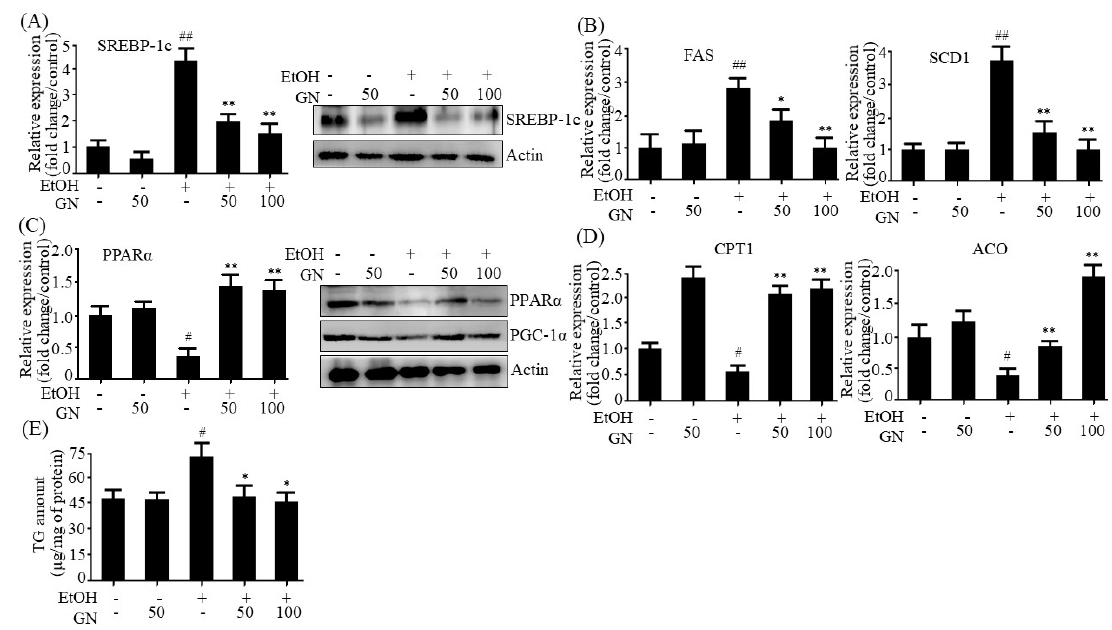
Figure 6. Gomisin N prevents ethanol-induced intracellular TG accumulation in HepG2 cells. HepG2 cells were treated with 50 mM ethanol in the presence or absence of GN (50 or 100 μM) for 24 h. ( A ) qPCR and western blot analysis of hSREBP-1c. ( B ) qPCR analysis of hFAS, and hSCD1. ( C ) qPCR and western blot analysis of hPPARα, western blot analysis of PGC-1α. ( D ) qPCR analysis of hCPT1, and hACO. ( E ) Measurement of intracellular TG levels. Values are the mean ± SD of triplicate experiments. # p < 0.05, ## p < 0.01 vs. untreated control, * p < 0.05, ** p < 0.01 vs. ethanol-treated group.